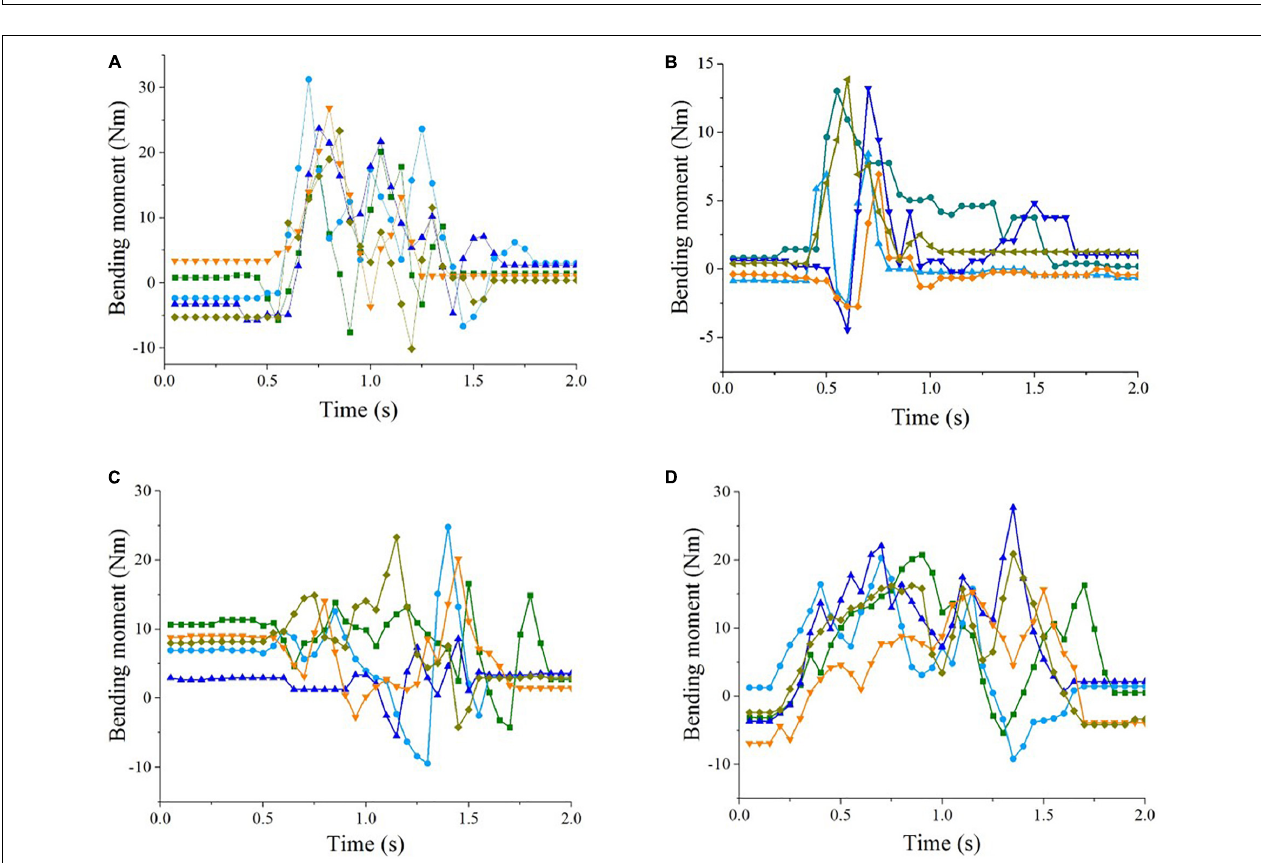
ear was prone to be miss picked, and the header was prone to be blocked, as shown in Figure 11D . This result differed from the conclusions of Xue et al. (2020a) that the lowest loss occurred when the corn was harvested in the reverse direction of lodging.